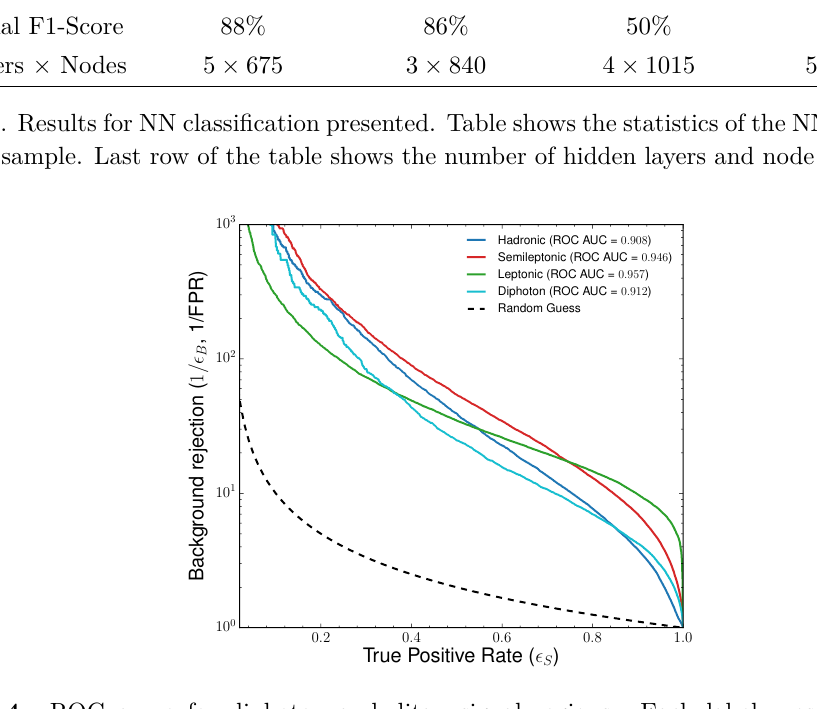
Figure 4 . ROC curve for diphoton and ditau signal regions. Each label presented with the corresponding area under TPR-FPR curve. The colors blue, red, green and cyan represents ditau hadronic, ditau semileptonic, ditau leptonic and diphoton signal